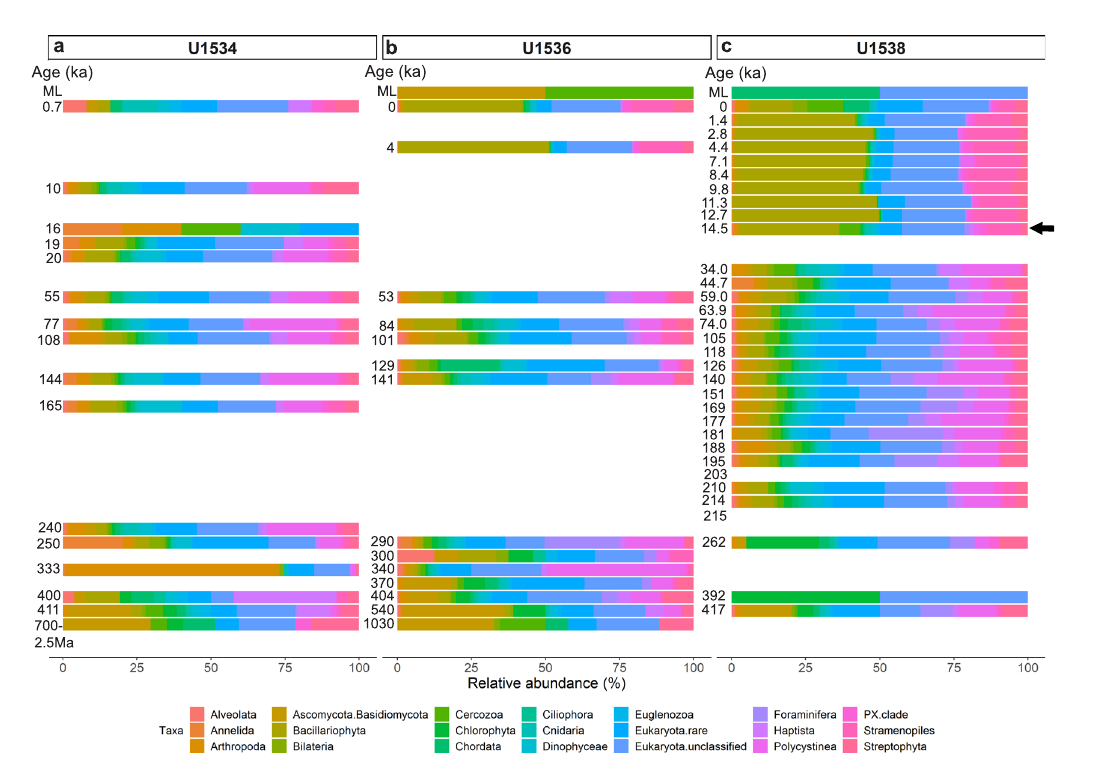
Fig. 3 | Relative eukaryote abundance at IODP Exp. 382 Sites U1534, U1536, U1538. Relativeabundanceofeukaryotesisshownatphylum-levelasderivedfrom sed aDNAatExp.382SitesU1534(HoleC)( a ),U1536(HoleB)( b )andU1538(HolesC and D) ( c ) post combined SSU+LSU alignment. Taxa abundant with at least 1% on average across all samples are shown separately, less abundant taxa are grouped as ‘ Eukaryota.rare ’ . Left axis shows the estimated age (where an age but no bar is